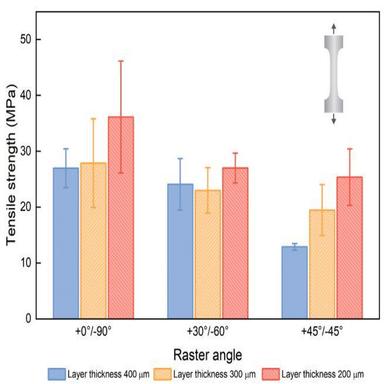
Comparison of tensile strength of 3D printed zirconia at different layer thicknesses and raster angles.